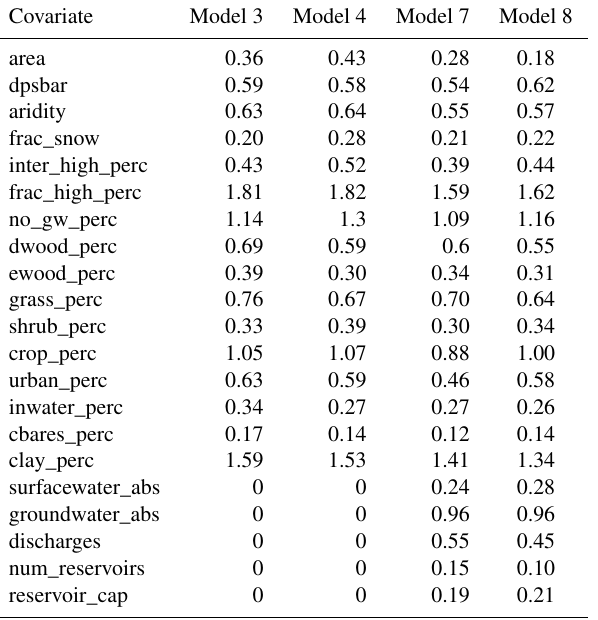
Table 3. Score of the relative importance of covariates in RF model. Covariate Model 3 Model 4 Model